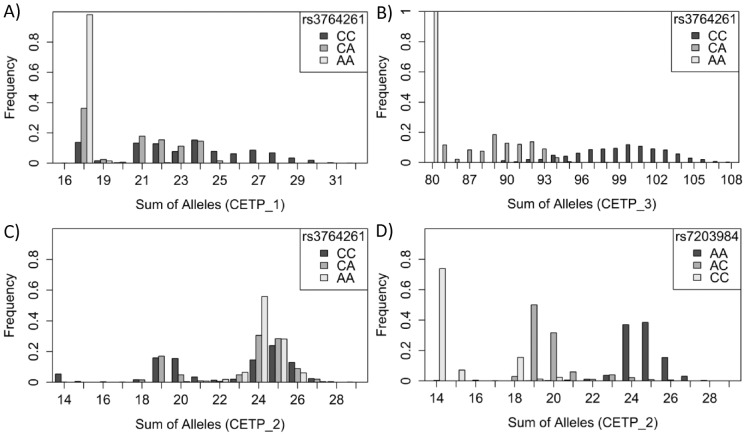
Distribution of sum of STR-alleles, separated for genotypes:A) Distribution of CETP_1, separated for rs3764261 genotypes, B) Distribution of CETP_3, separated for rs3764261 genotypes, C) Distribution of CETP_2, separated for rs3764261 genotypes, D) Distribution of CETP_2, separated for rs7203984 genotypes.